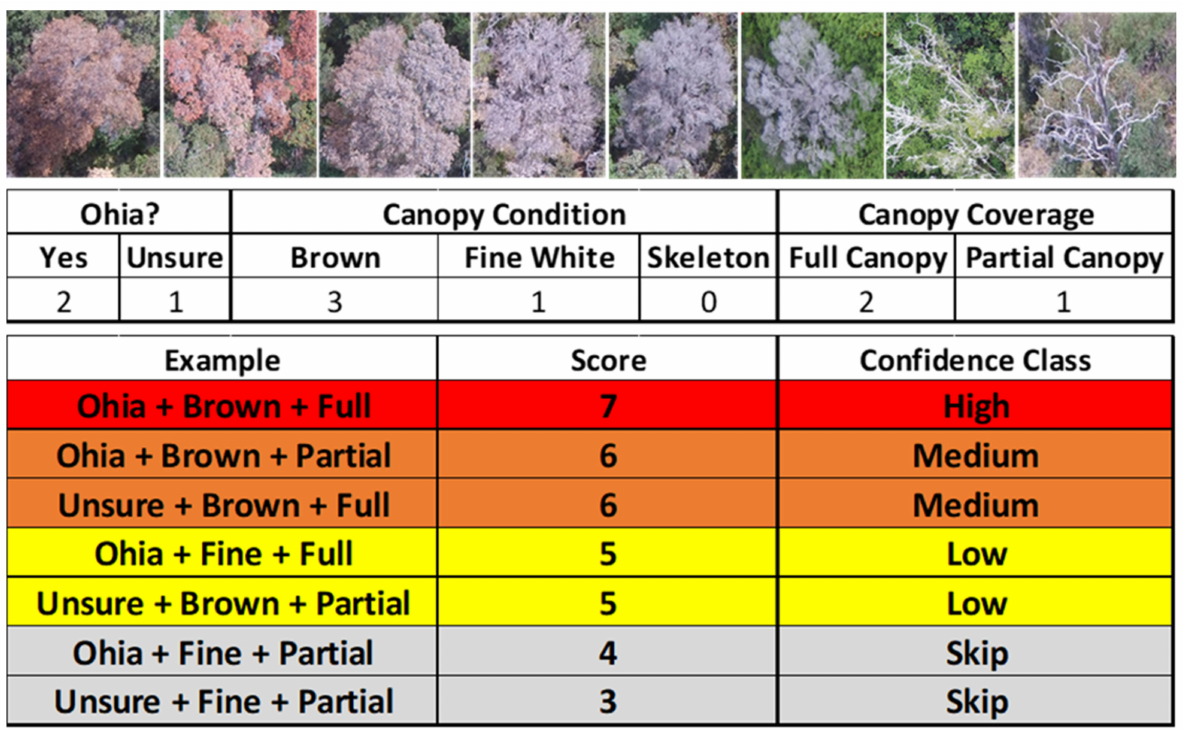
Figure 4. ( Top ) Examples of late-stage ROD canopy conditions as observed from aerial imagery, ( Middle ) Factors used to determine ROD confidence rating scores ( Bottom